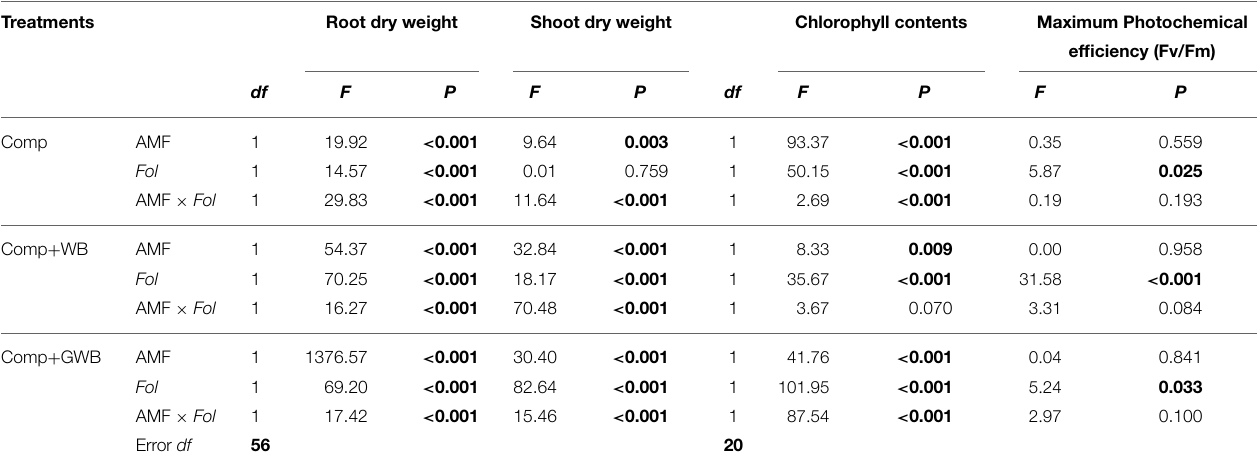
Significant P values (P < 0.05) are in bold.